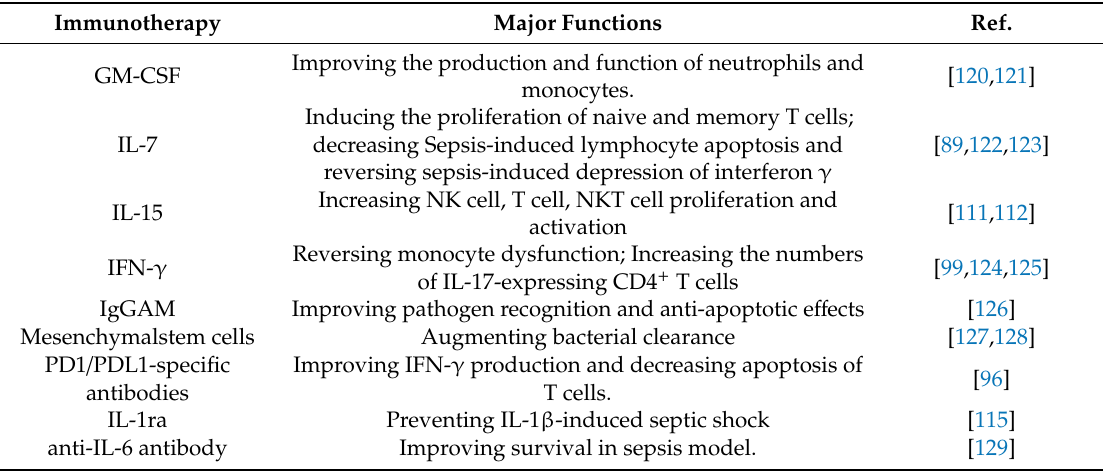
Table 2. New approaches: Immunotherapies in